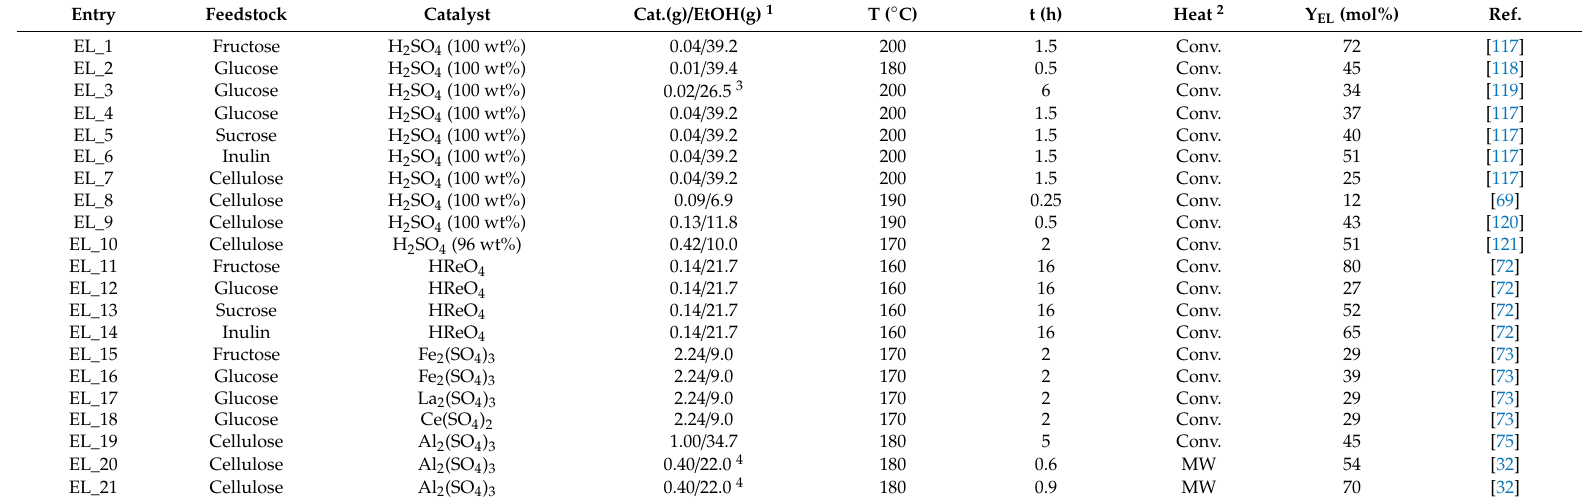
Table 7. Inorganic mineral acids and metal salts for the ethyl levulinate (EL) production from C6 model